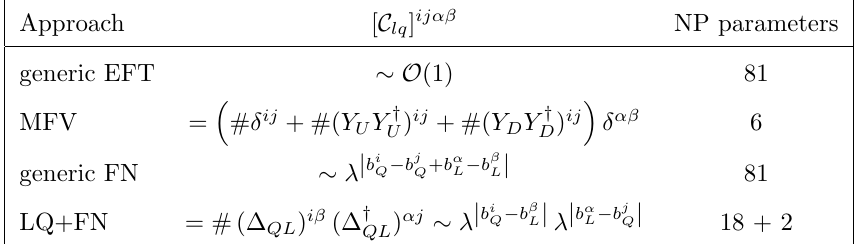
Table 1 . Cabibbo-scaling and factorisation of the (cid:13)avour coe(cid:14)cient C lq in di(cid:11)erent theoretical approaches, and the resulting reduction of NP